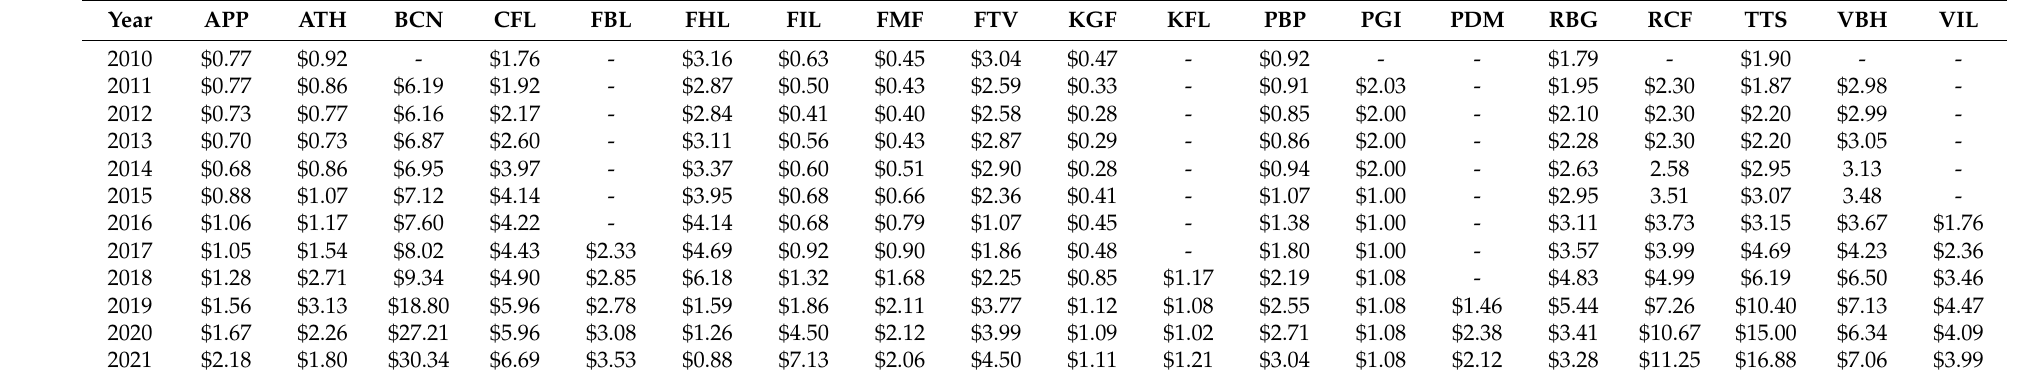
Table 7. Average Share Price Per Year.